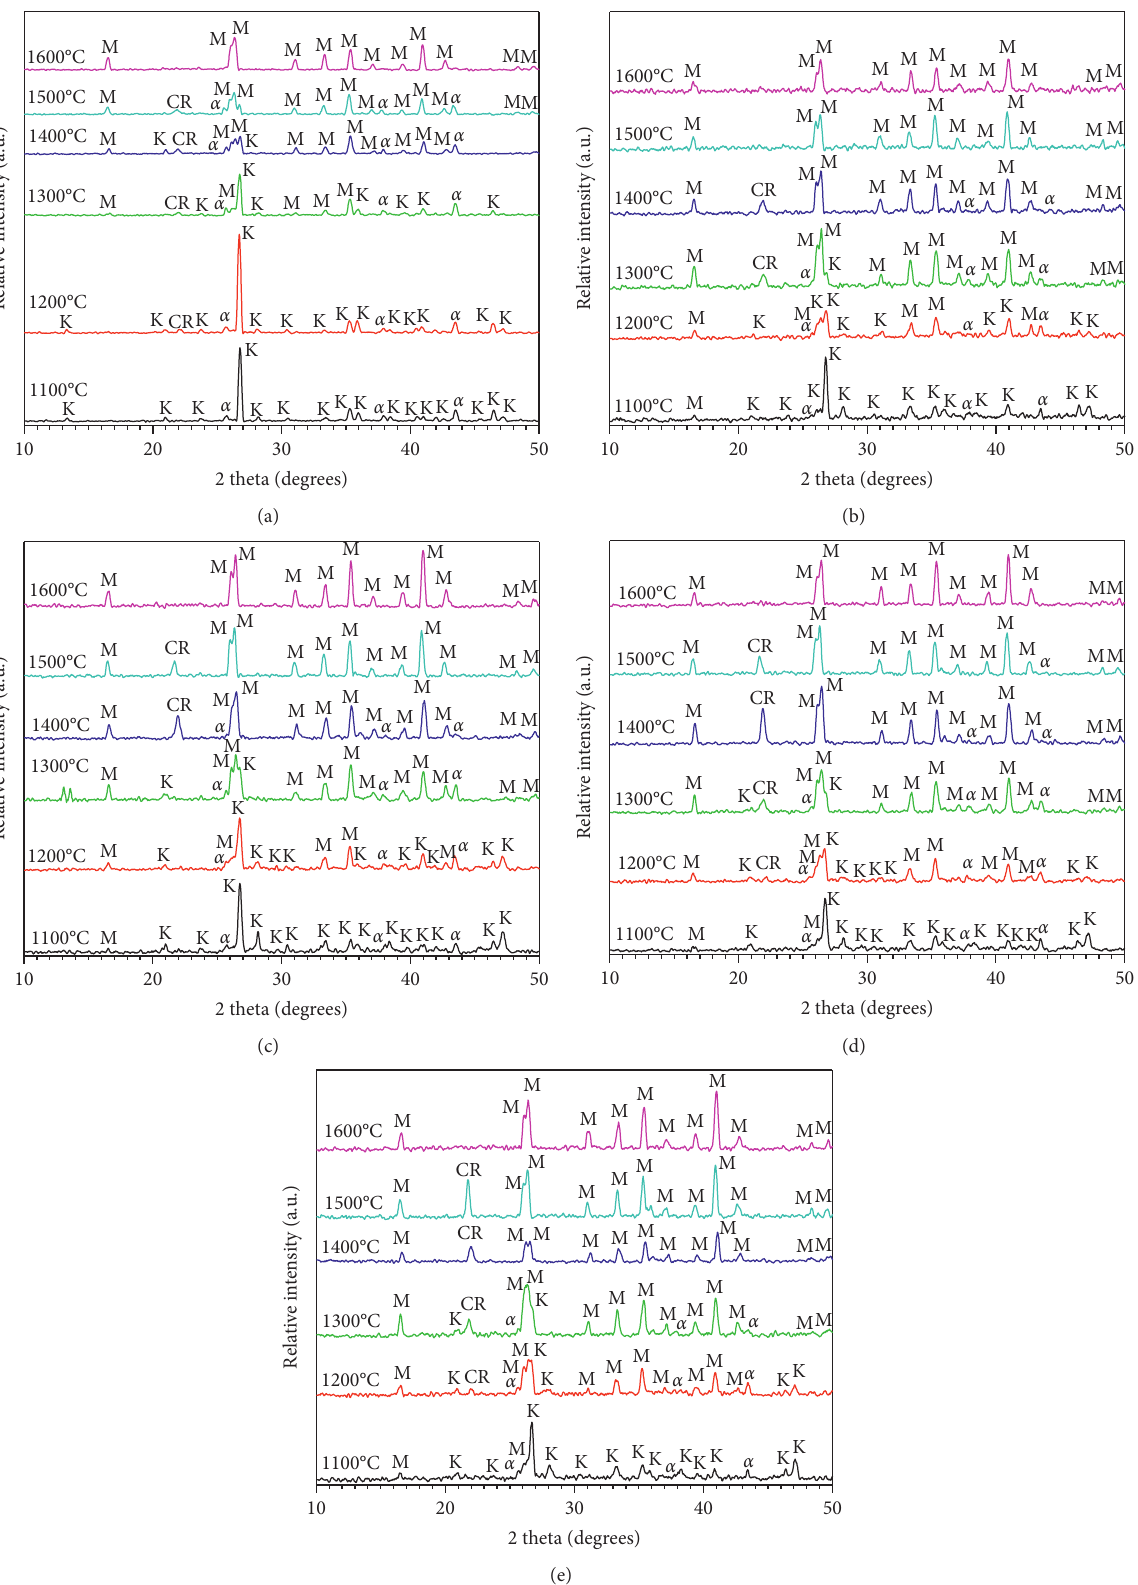
Figure 6: XRD patterns of mixture of kyanite-aluminum powder milled at (a) KA0h, (b) KA0.5h, (c) KA3h, (d) KA6h, and (e) KA12h at different sintering temperatures. K � kyanite, A � aluminum, M � mullite, CR � cristobalite, and α � α -Al 2 O 3